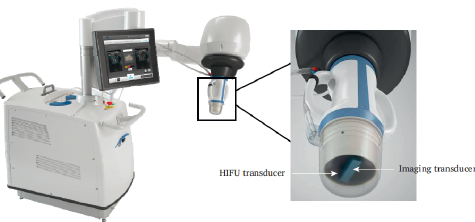
Figure 10. Sonovein system, developed by Theraclion, is intended for the treatment of varicose veins with sub-millimeter precision [20].